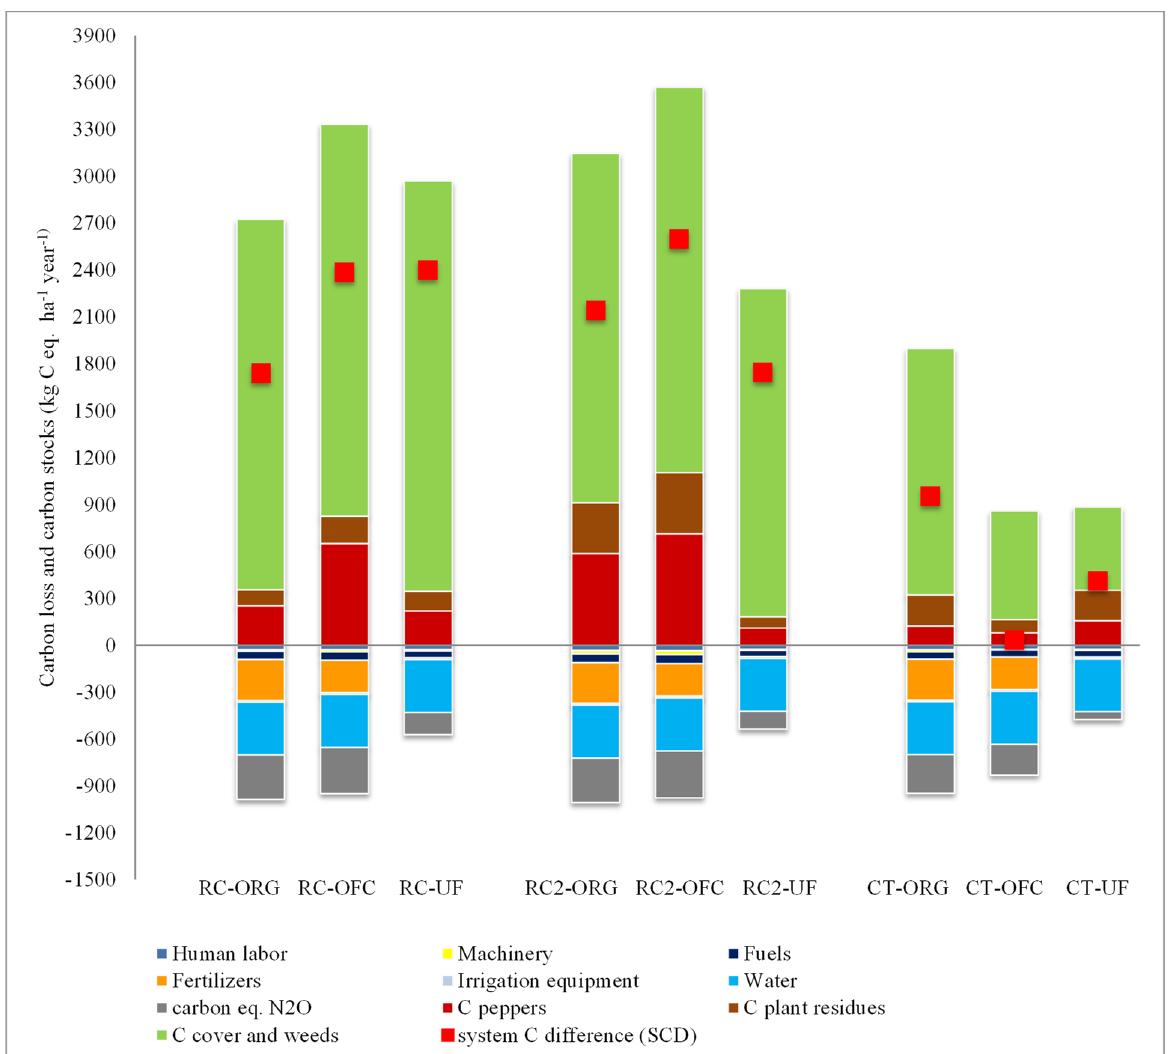
Figure 5. Carbon loss (emissions), carbon stocks and system carbon difference (SCD) expressed as Kg C eq. ha − 1 year − 1 in the different analyzed systems. RC = mix of vetch-oats; RC2 = mix of vetch-rice; CT = no cover crops; ORG = organic commercial fertilizer; OFC = on-farm compost; UF = unfertilized control.